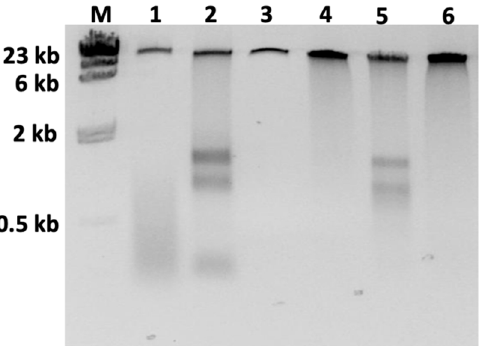
Figure 1. Agarose gel electrophoresis of 120 ng DNA extracted from rooibos leaves using either SDS or CTAB extraction protocols. Lane M: HindIII molecular weight marker; Lane 1: SDS, unpurified; Lane 2: CTAB, unpurified; Lane 3: CTAB, ZymocleanTM Large Fragment DNA Recovery Kit; Lane 4: CTAB, QIAGEN ® DNeasy PowerClean CleanUp Kit; Lane 5: CTAB, Genomic-tip 1; Lane 6: CTAB, Genomic-tip